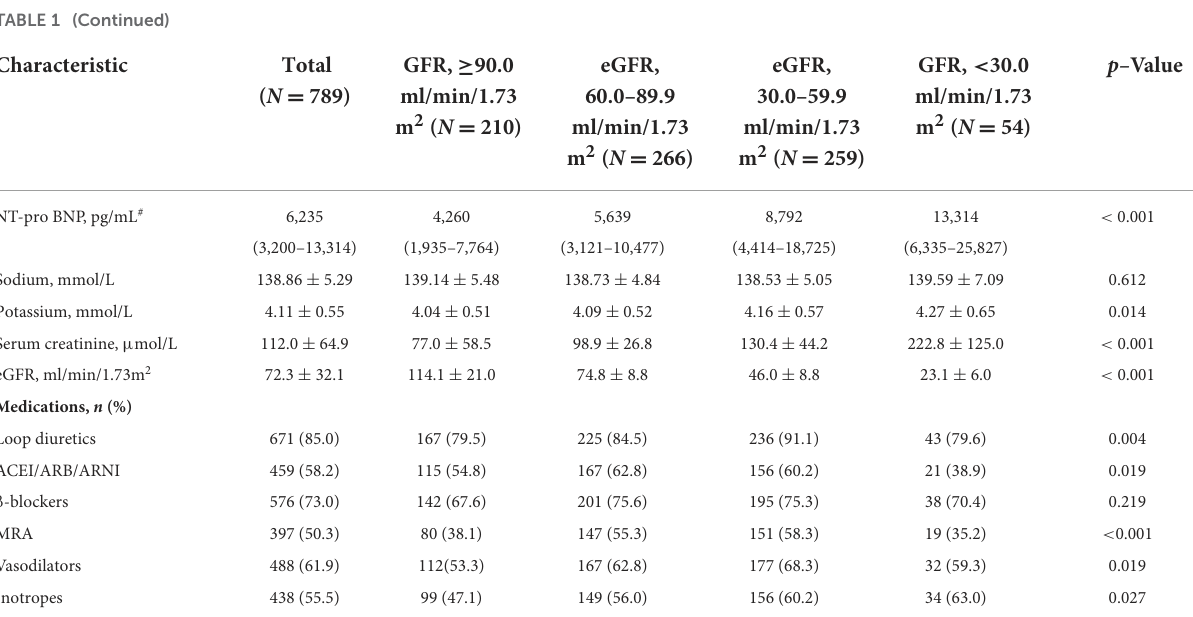
shown in Figure 4, the eGFR levels increased after levosimendan infusion in patients with eGFR lower than 90.0 ml/min/m 2 . On the contrary, levosimendan infusion did not result in an increase in eGFR level in patients with the highest baseline eGFR levels.